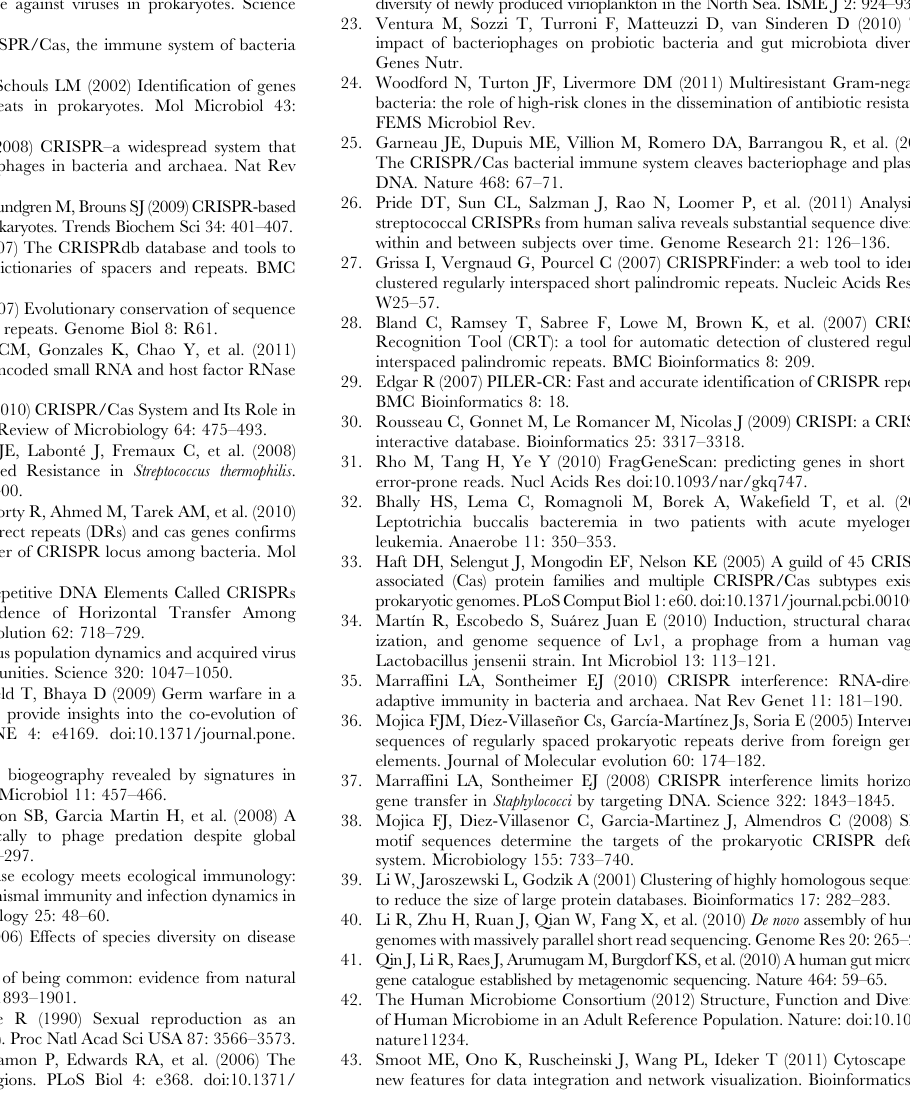
Table S1 List of 150 CRISPRs studied in this manuscript and the targeted assembly results in the HMP datasets. Table S2 List of CRISPRs that are identified from the reference genomes, and their cross-references in the CRISPRdb. Table S3 List of numbers of datasets from different body sites that have reads (the first number) or CRISPRs (the second number) identified for each CRISPR. Table S4 List of viral genomes and their accession IDs plotted in Figure 6A. Table S5 List of viral genomes sharing high sequence similarities ( $ 90% identify over 30 bps) with CRISPR spacers.